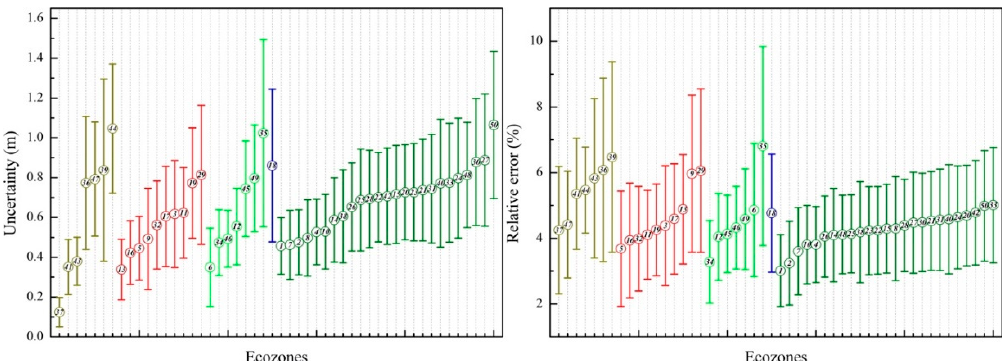
Figure 12. Distribution of uncertainty ( left ) and relative error ( right ) values in 50 ecozones. Colors indicate different ecozones: dark yellow represents deserts, red is agricultural areas, light green is grasslands, olive indicates forests, and blue is special ecozone in the Three Gorges Reservoir. Numbers in circle represent the different kinds of ecozones, and the bar represents the standard deviation.